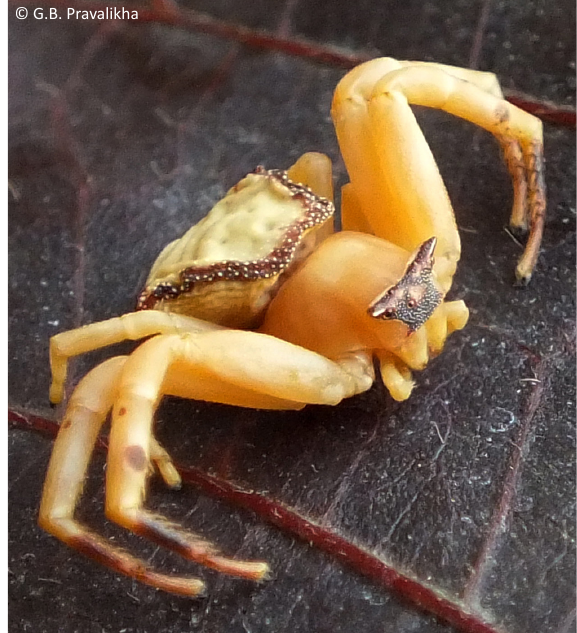
Image 5. Thomisus projectus Tikader, 1960 live habitus.